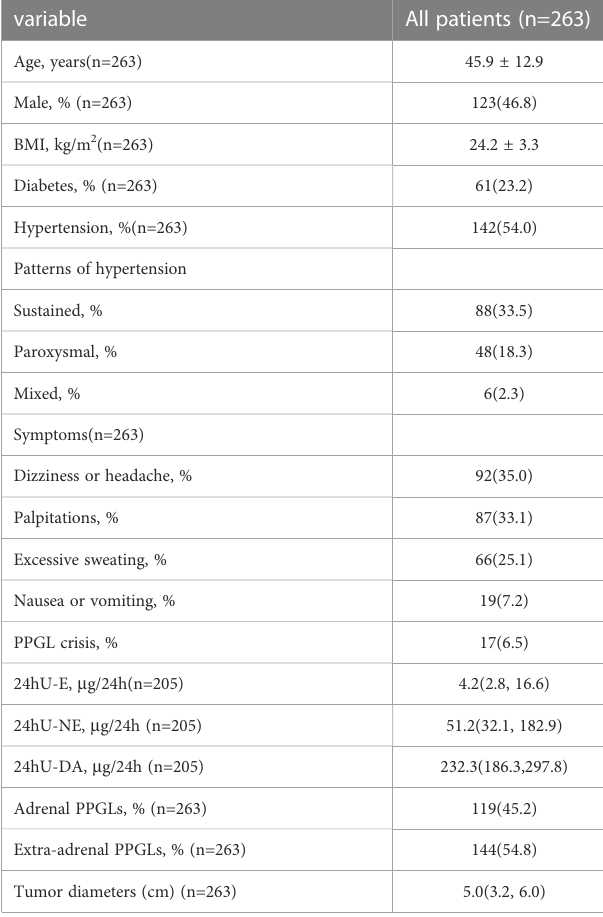
TABLE 1 Clinical characteristics of patients with PPGLs at initial